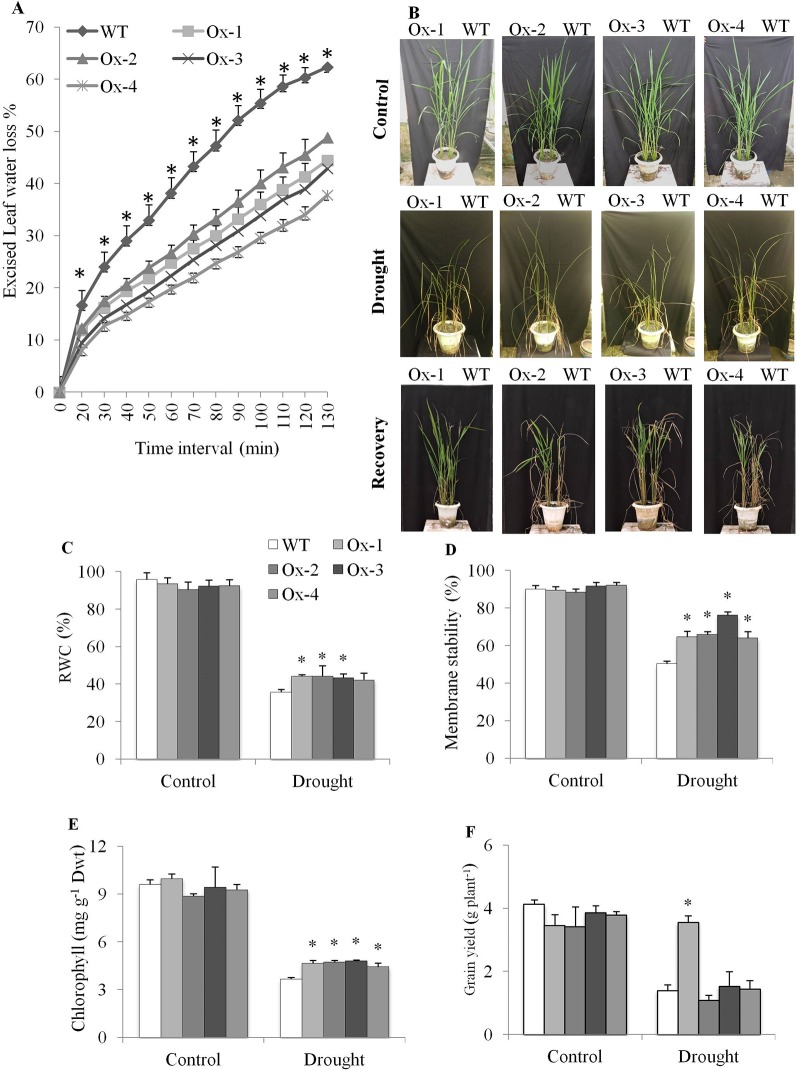
Drought tolerance of OsPYL10 overexpressing transgenic rice at reproductive stage. (A) Excised leaf water loss from excised flag leaves at different time interval of dehydration. The ELWL of transgenic events Ox1, Ox3 and Ox4 were significantly lower than that of WT plants from 20 minutes onwards, while that of Ox2 event was significantly lower than the WT plants from 30 minutes onwards. (B) Phenotype of OsPYL10 transgenic rice and WT plants under drought and recovery. Plants were exposed to drought (∼ -80 kPa) and recovered by irrigation. (B–E) RWC%, membrane stability, chlorophyll content of transgenic and WT plants under drought stress. Flag leaf was used for all estimation. (F) Grain yield under control and drought stress. The experiments were performed with three biological replicates and graph shown the mean value (n = 3). Error bar indicates ± SE. *means P < 0.05.